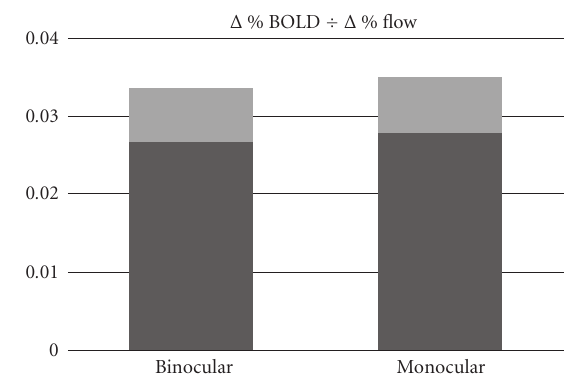
Figure 4: Percent change ratios ( ± SE in lighter shade of gray) for BOLD and CBF during binocular and monocular stimula- tion. There is no significant di ff erence between the ratios for the two forms of stimulation, suggesting a comparable degree of flow- metabolism coupling throughout V1 regardless of the columnar fraction